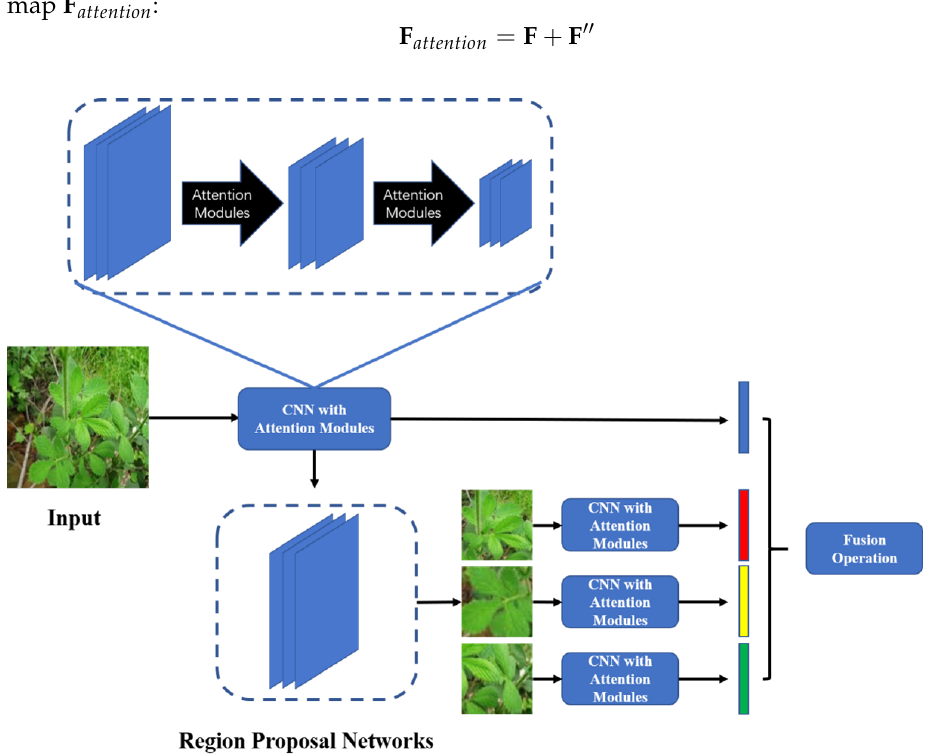
Figure 2. Attentive feature